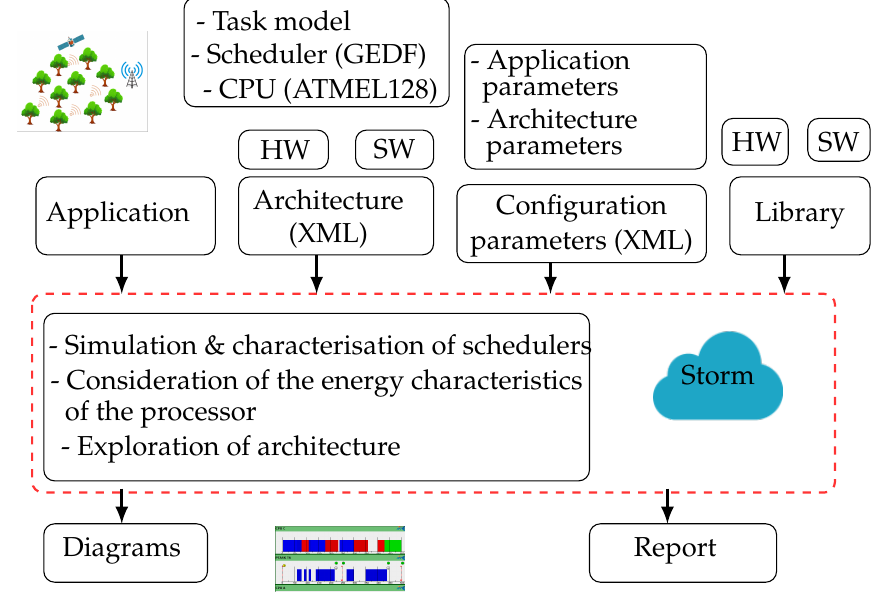
Figure 4. Backend Design of HEEPS Model.